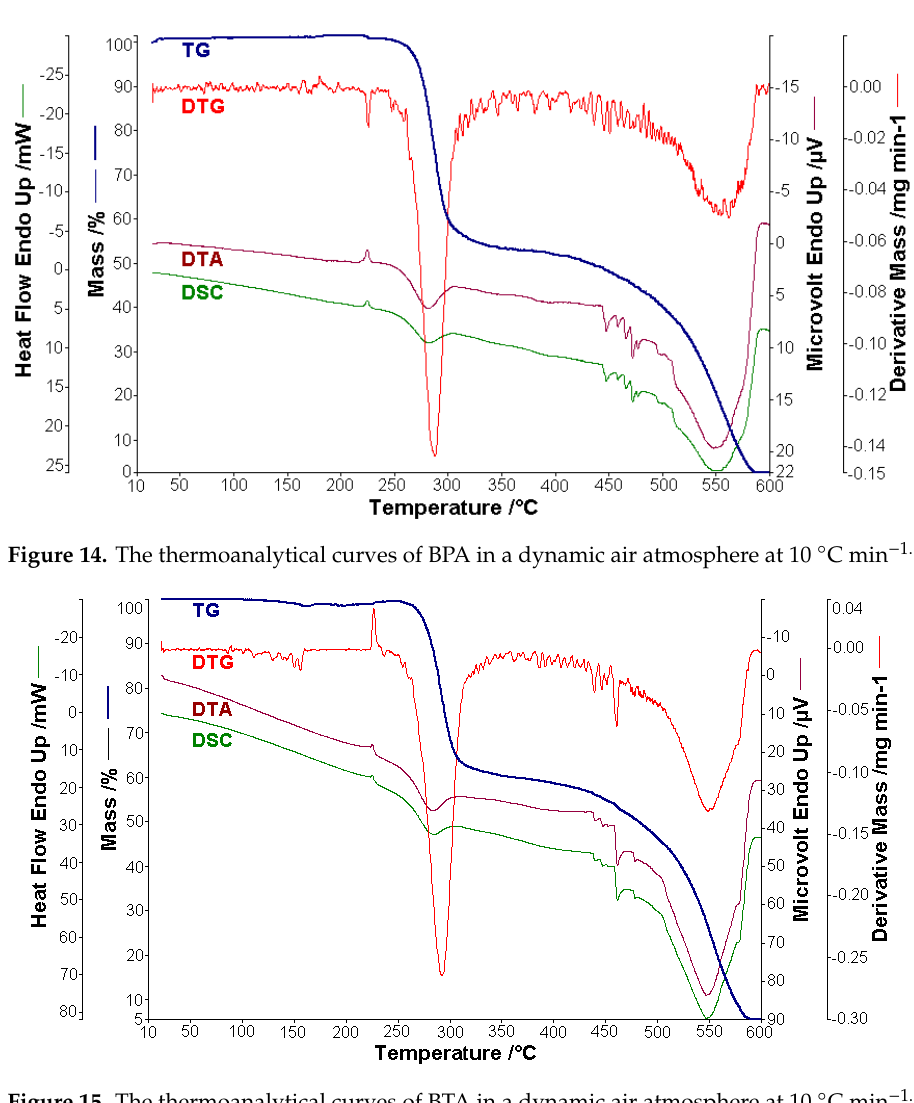
Figure 15. The thermoanalytical curves of BTA in a dynamic air atmosphere at 10 °C min − 1.